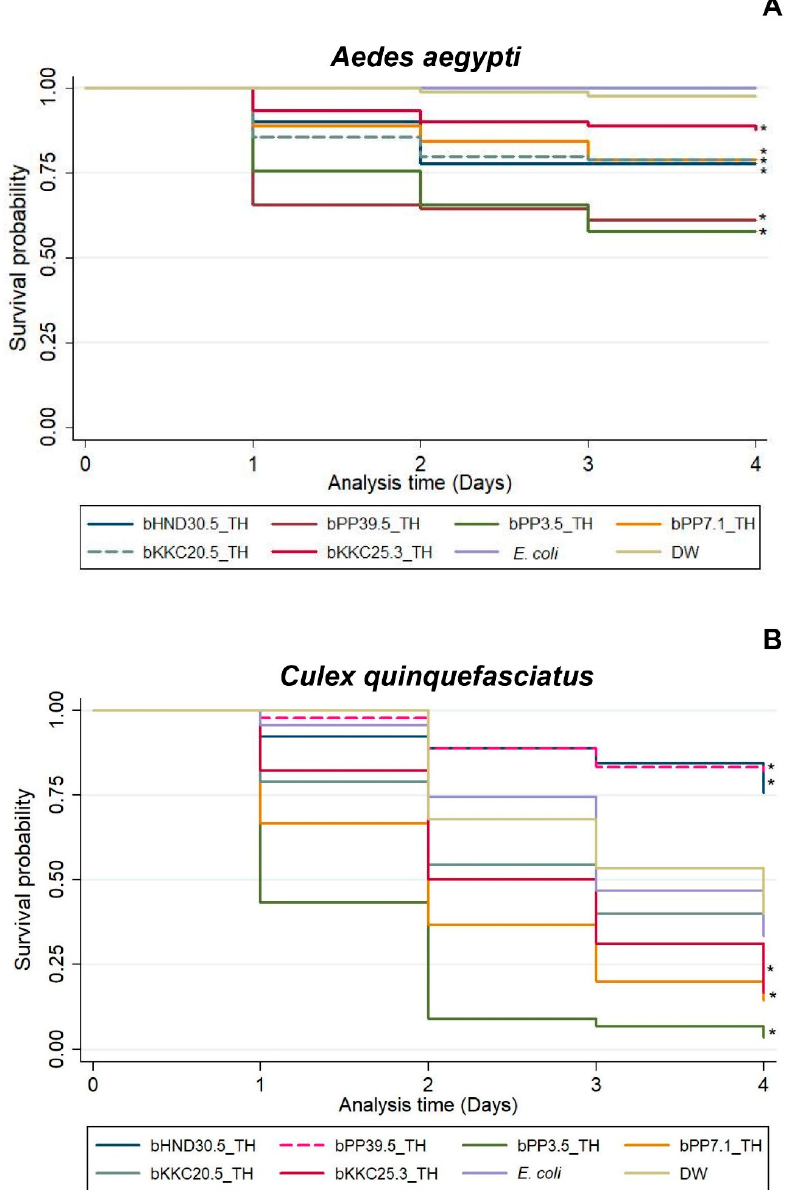
25922 and distilled water for 96 h, respectively. All isolates of symbiotic bacteria tested against Ae. aegypti larvae showed significant differences compared to controls at p -value ≤ 0.05 (Table S6). The larvae of Cx. quinquefasciatus exhibited a high mortality after exposure to Photorhabdus bPP3.5_TH for 24 h. The mortality of Cx. quinquefasciatus was similarly high (83.33–96.67%) after exposure to Photorhabdus isolates (bKKC25.3_TH, bPP3.5_TH and bPP7.1_TH) for 96 h. However, in the control, the mortality of Cx. quinquefasciatus was also high after exposure to Escherichia coli ATCC 25922 and distilled water for 96 h. Other isolates of symbiotic bacteria tested against Cx. quinquefasciatus larvae showed significant differences compared to control groups at p -value ≤ 0.05 (Table S7).